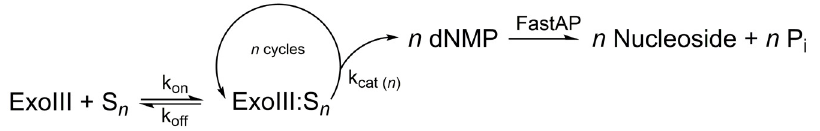
Fig 1. Kinetic model of Exonuclease III hydrolysis of a dsDNA substrate with n nucleotides susceptible to hydrolysis.